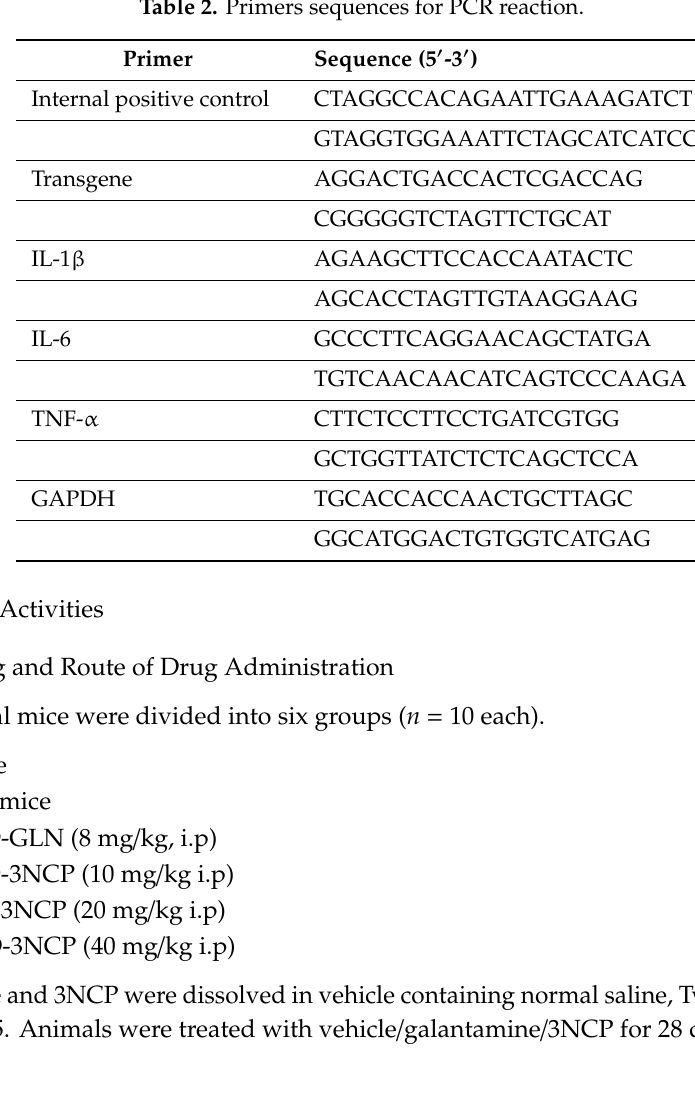
Table 2. Primers sequences for PCR